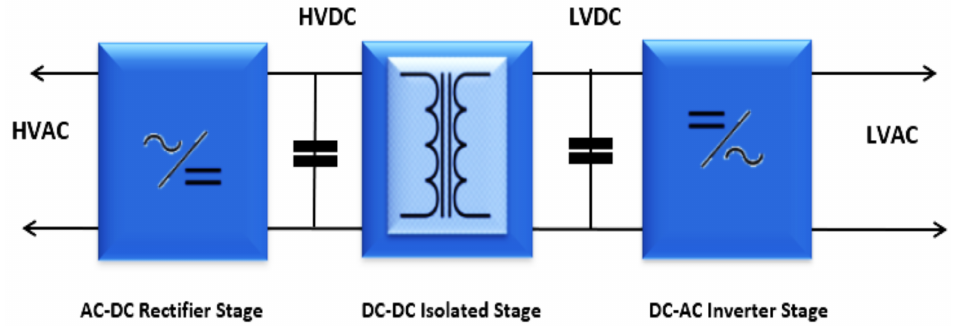
Figure 1. Three-stage SST